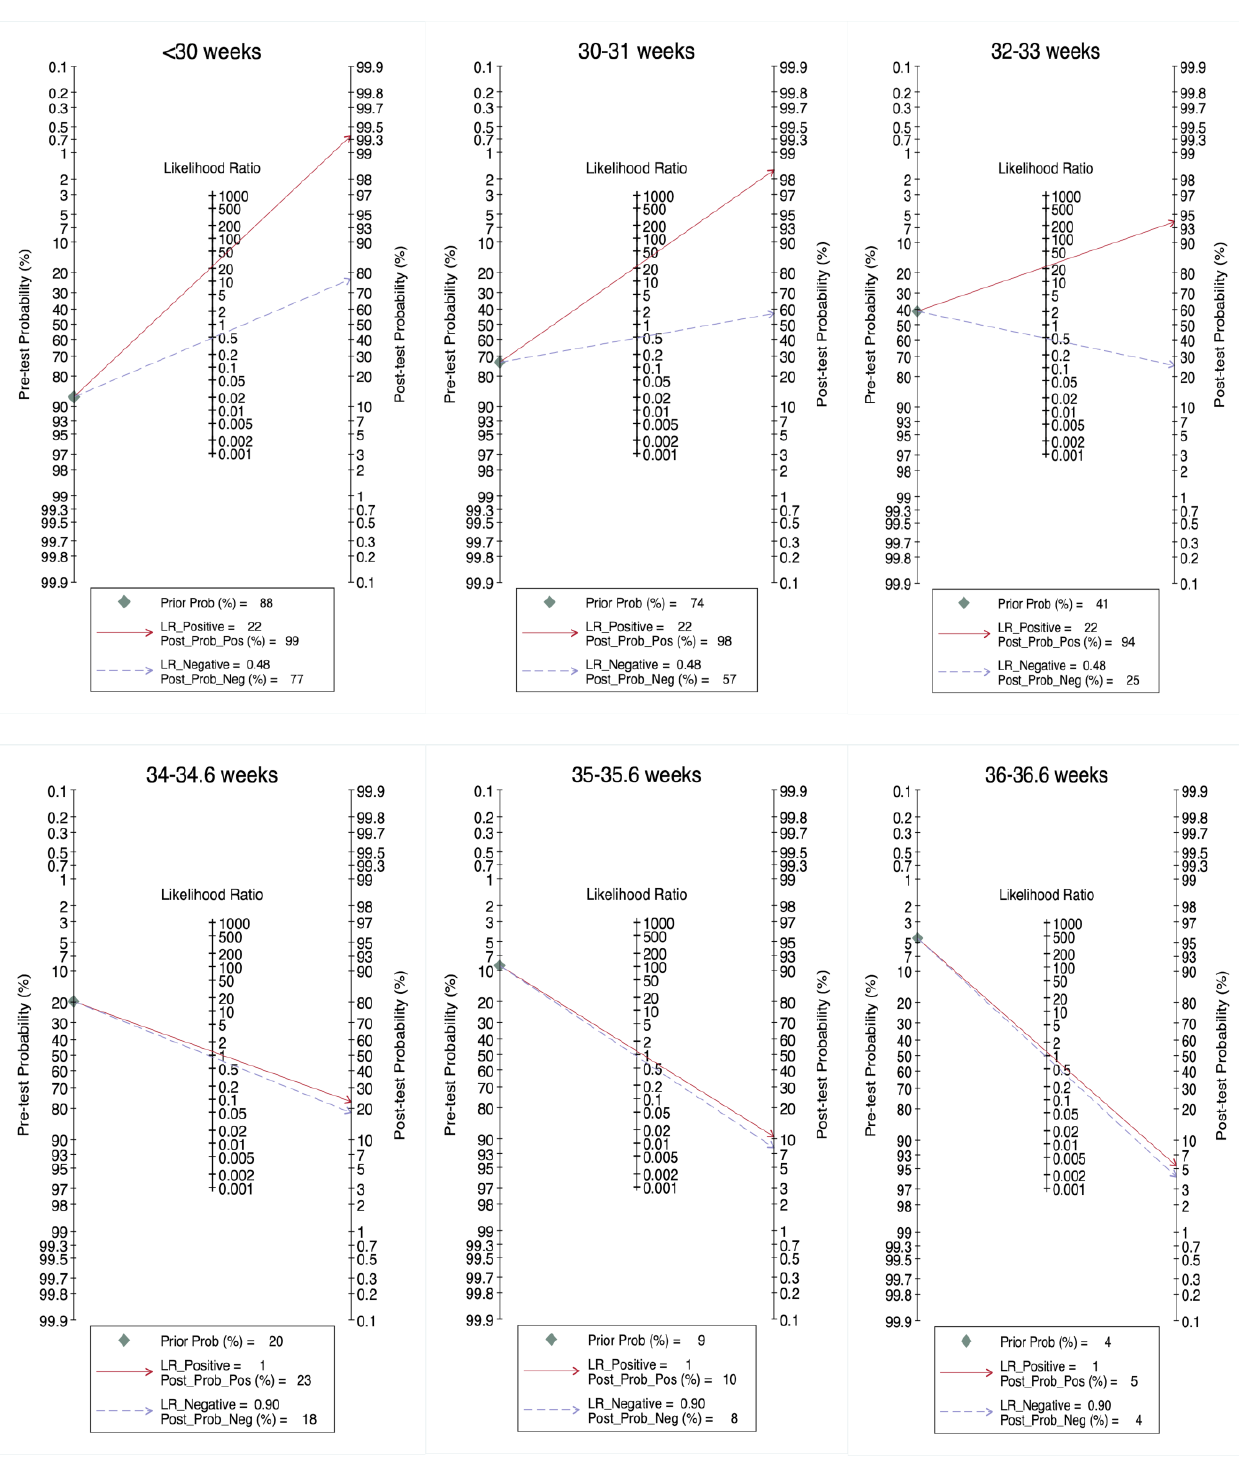
Figure 2. Fagan nomogram analysis to evaluate the clinical utility of the prediction of neonatal respiratory morbidity by quantusFLM ® in twin pregnancies. Pre-test probabilities of neonatal respiratory morbidity in twins were obtained from Clin Chim Acta 484 (2018) 293–297 for <30.0 up to 33.6 weeks [22] and from BMJ 2016;354: i4353 for 34.0 up to 36.6 weeks of gestation [3].